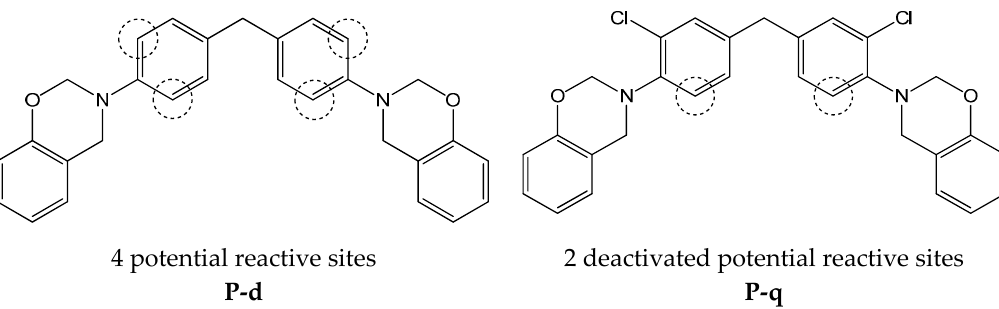
Figure 6. Possible reactive sites in the aromatic ring of the diamines and influence of substituents.